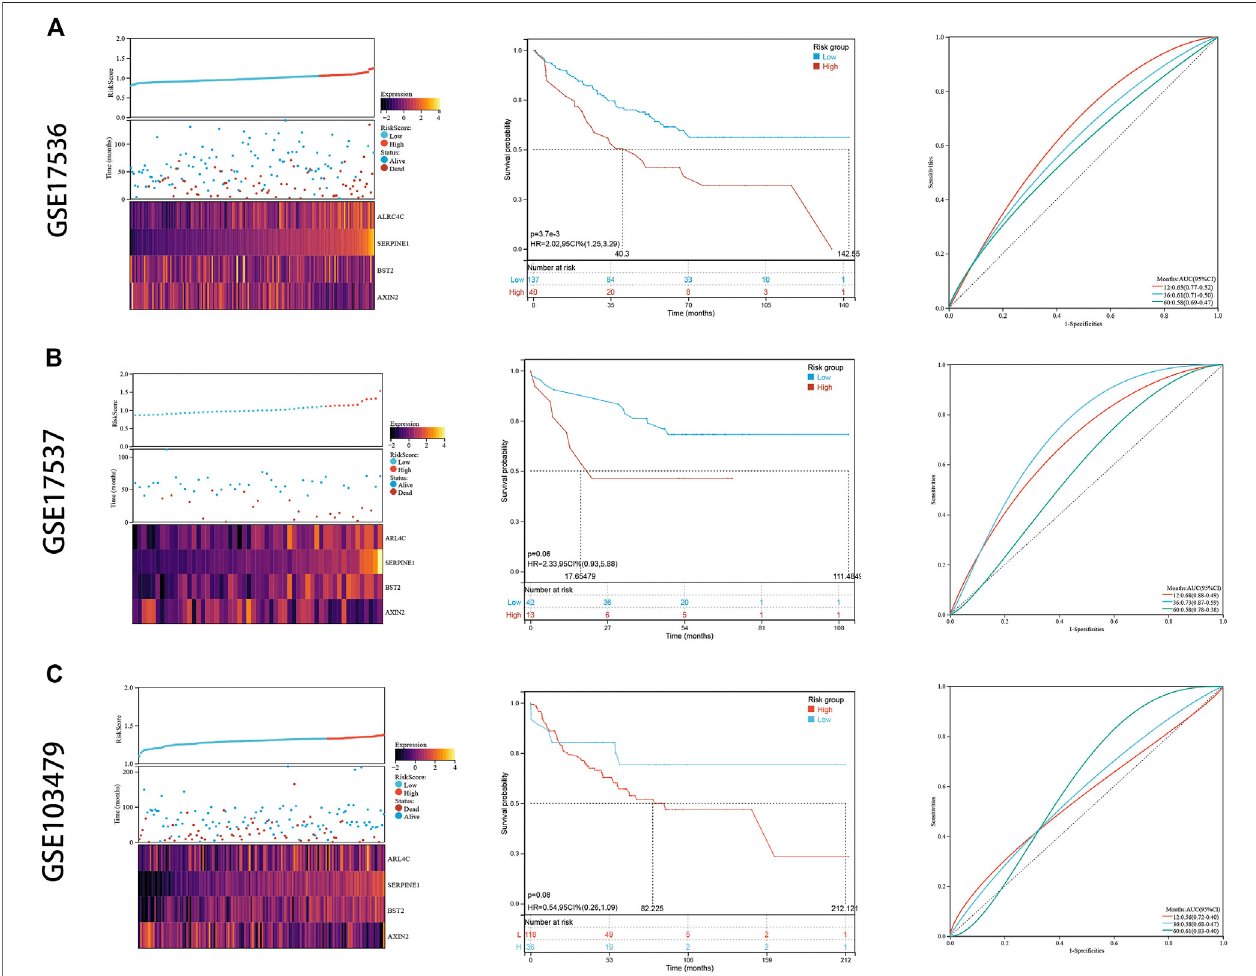
FIGURE 7 | External validation. (A) The risk distribution, the Kaplan – Meier survival curve, and the ROC curves in GSE17536. (B) The risk distribution, the Kaplan – Meier survival curve, and the ROC curves in GSE17537. (C) The risk distribution, the Kaplan – Meier survival curve, and the ROC curves in GSE103479.